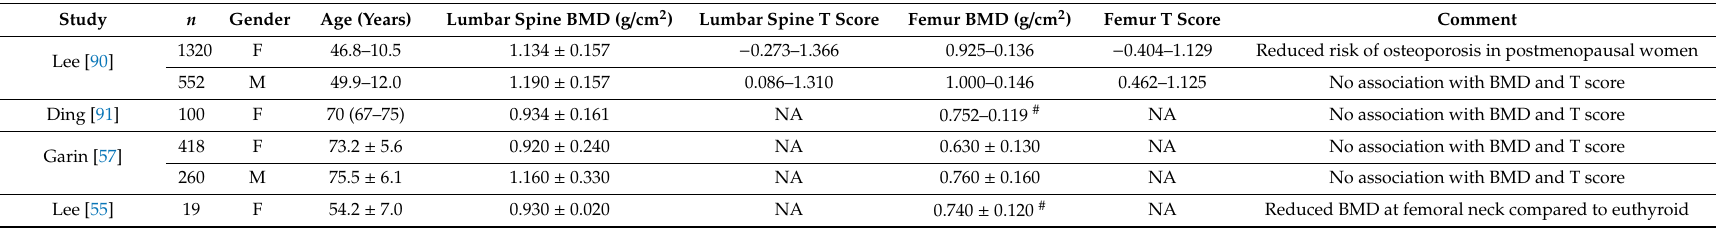
Table 5. Studies that analyzed the e ff ect of subclinical hypothyroidism on lumbar spine bone mass density and femoral bone mass density.